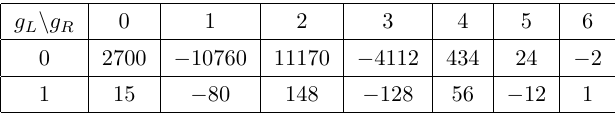
) = (2 , 1) in the B , d E